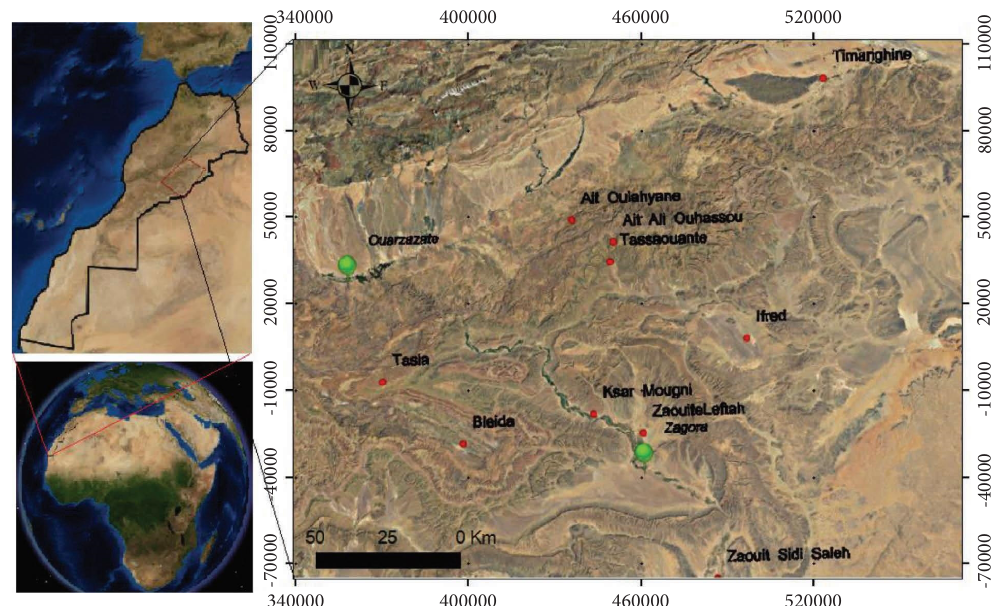
Figure 1: Study area and location of the ten study villages in Zagora